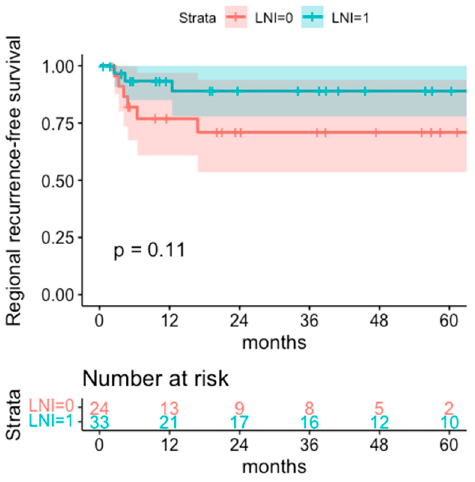
Figure 4. ( a ) Local and ( b ) distant recurrence-free survival of the cohorts with regional lymph node irradiation (LNI = 1) or without regional lymph node irradiation (LNI = 0). Regional recurrence-free survival is higher in the LNI cohort with 93.4% and 89.0% (95% CI 85.0–100% and 77.8–100%) after 1 year and 3 years, respectively, versus 76.9% and 71.0% (95% CI 60.9–97.0% and 53.6–93.9%) in the cohort without LNI, however statistical significance is not reached ( p = 0.11) (Figure 5). All tumor recurrences were observed